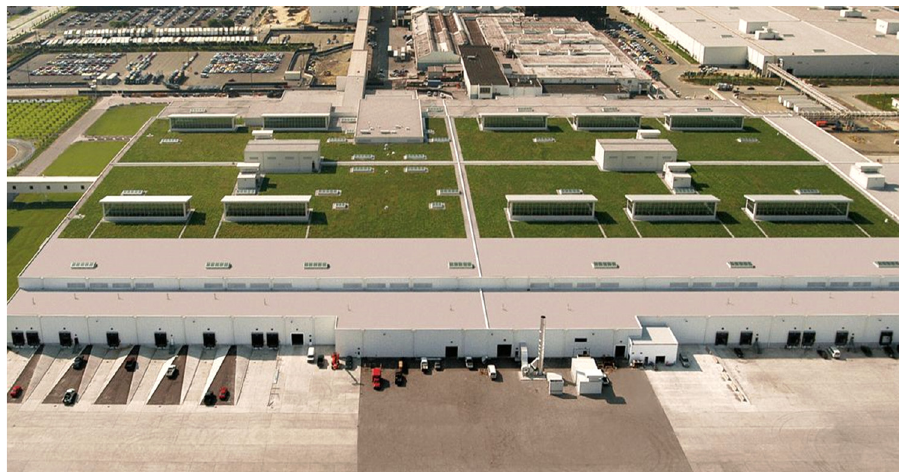
Figure 1: The Green Roof of the River Rouge Ford Complex. Aerial photo, November 2007. Photo Courtesy of Xero Flor